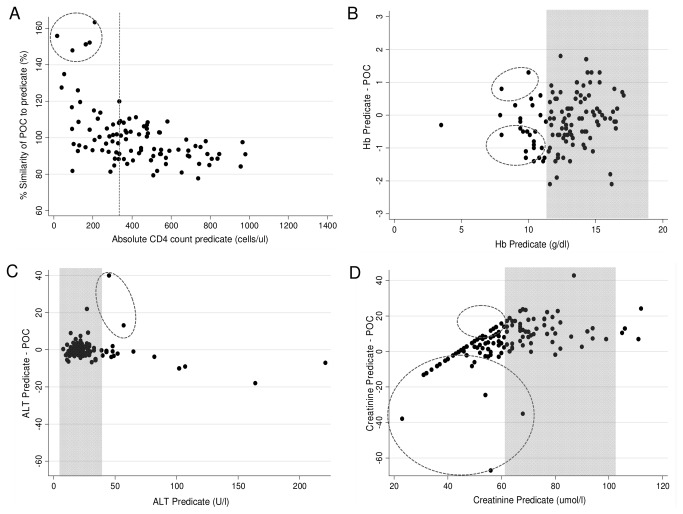
Scatter plots of method comparison for POC testing from multiple fingersticks compared to routine laboratory methodology (Phase I).The vertical axis in each plot is either percentage similarity (A) or difference (B-D) between POC and predicate and the horizontal axis is the absolute value of predicate tests: A) Percentage similarity for CD4. Red dashed line indicates misclassification point of 350 cells/ul and circle highlights outliers. B-D) Bland Altman difference scatter plots for POC versus predicate methodology for Hb (B), ALT (C) and Cr (D). Grey areas indicate normal ranges for analytes based on predicate method and circles highlight outliers mostly based on RCPA guidelines.